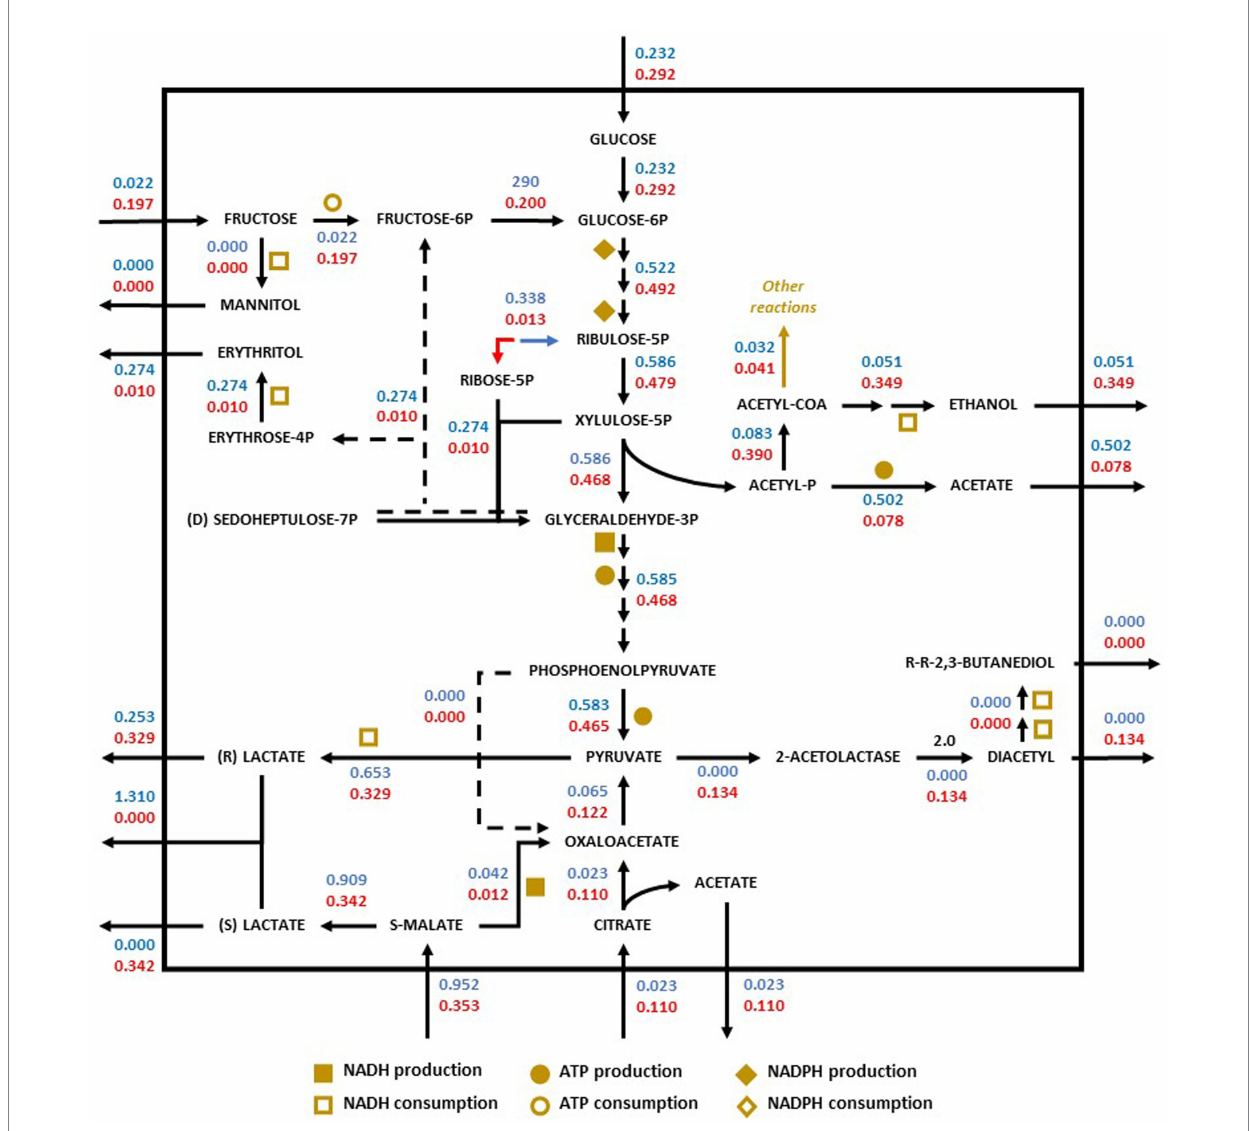
FIGURE 5 Redistribution of the metabolic flux of the strains O. oeni PSU-1 (blue) and O. oeni E1 (red) evaluated using Chardonnay. Square, circle, and diamond polygons indicate consumption (or production) of NADH, ATP, and NADPH, respectively. S-malate corresponds to L-malate. S-and R- lactate correspond to L-and D lactate, respectively.